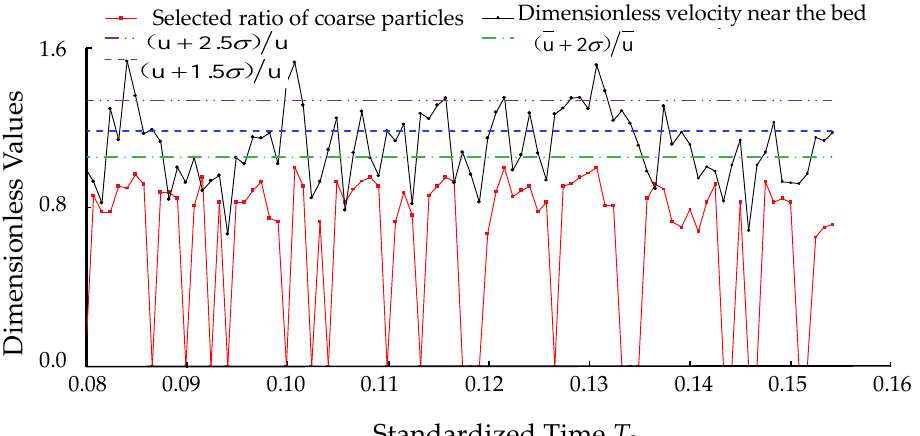
Figure 10. Trend comparison of the dimensionless near-bed velocity and selected ratio of the coarse sand ( Q = 0.03 m 3 /s, η = 7:3). The two progress curves indicate that the transport of the non-uniform bed load sediments obviously responds to the turbulence structures near the bed, and the transport event of coarse sands may be predicted by comparing the flow intensities with the value of the threshold lines, i.e., the dotted lines in the figure.